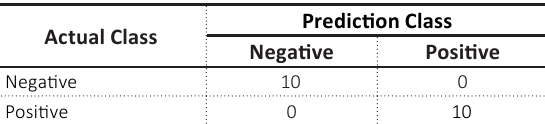
Table 6. Confusion matrix output training data